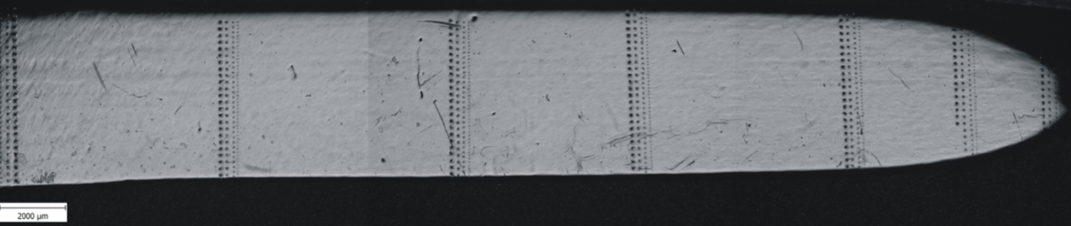
Table 1. Results of the tensile test: the reduction of the area Z (%), values of the micro-hardness and average micro-hardness HV , and the speed of the indenter. Area Z7 is the head and area Z1 is the neck of the tensile test